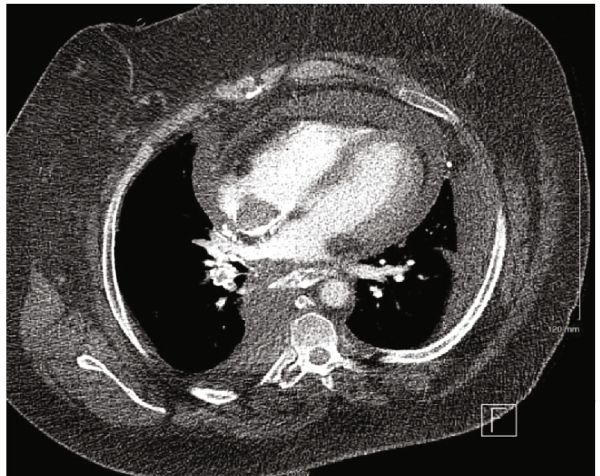
Figure 2: CT of the chest with right atrial thrombus and pericardial e ff